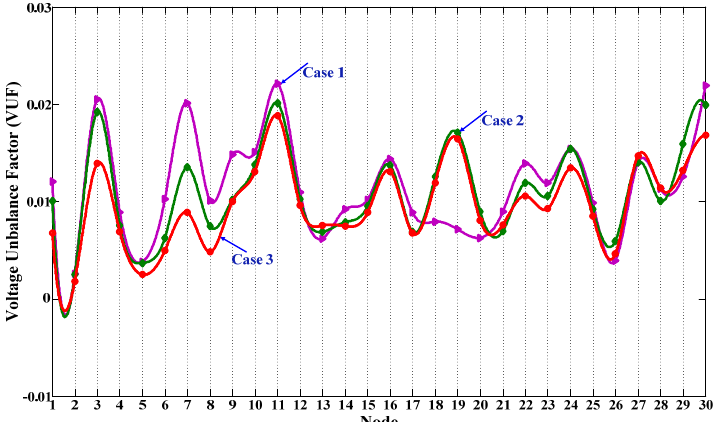
Figure 10. VUF (Voltage unbalance factor) at each node with added DGs in case n .